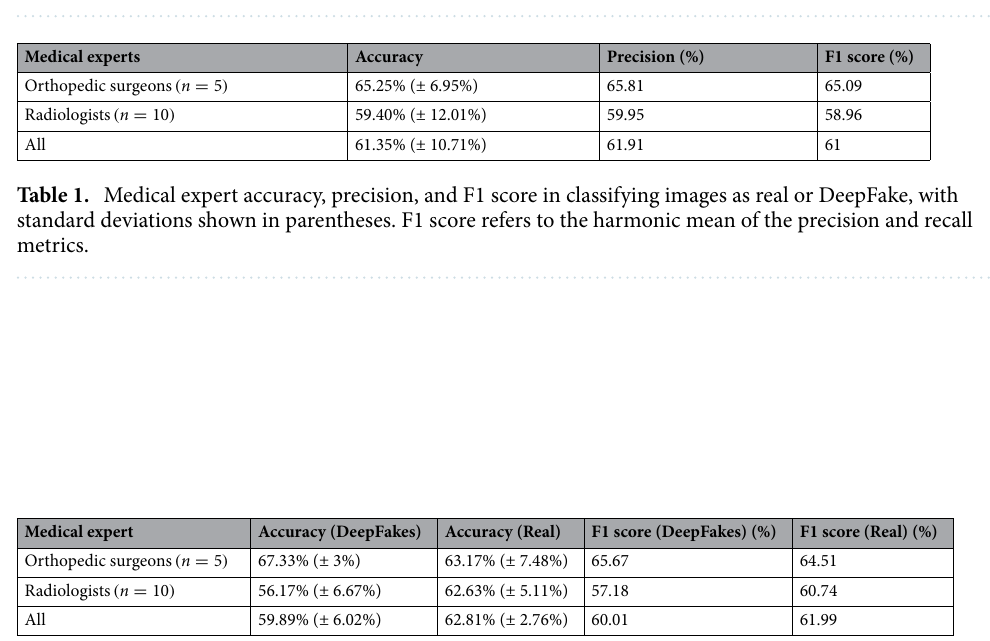
Figure 2. A sample from the survey images shown to medical experts. The top half includes KL01 DeepFake and real images, and the bottom half KL234 DeepFake and real images.